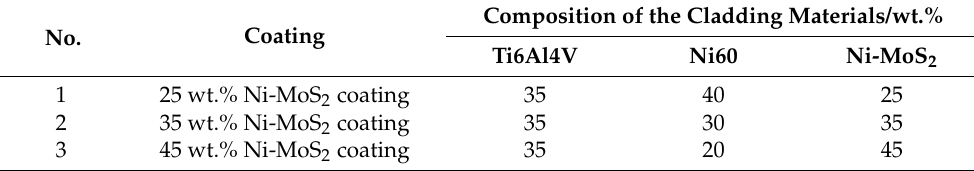
Table 1. The design of the coating cladding material system.